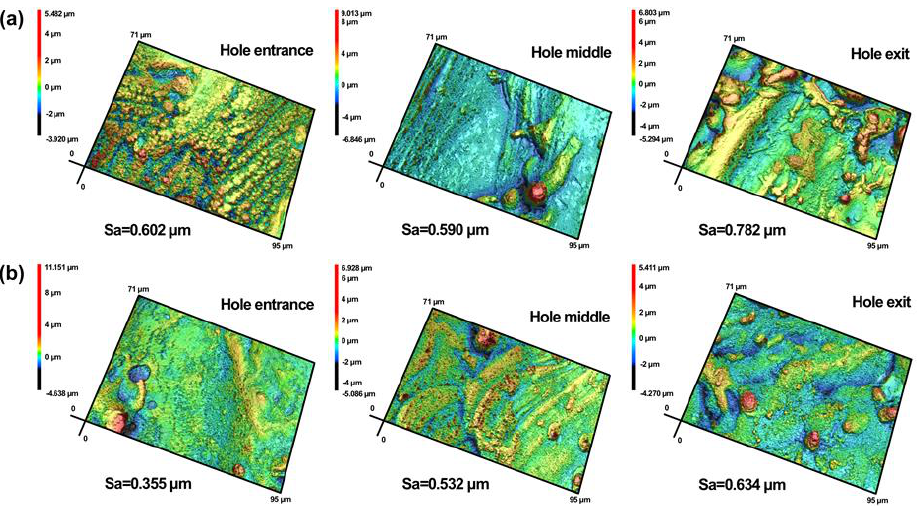
Figure 11. 3D morphology at different locations of hole sidewall: ( a ) in air, ( b ) water − based